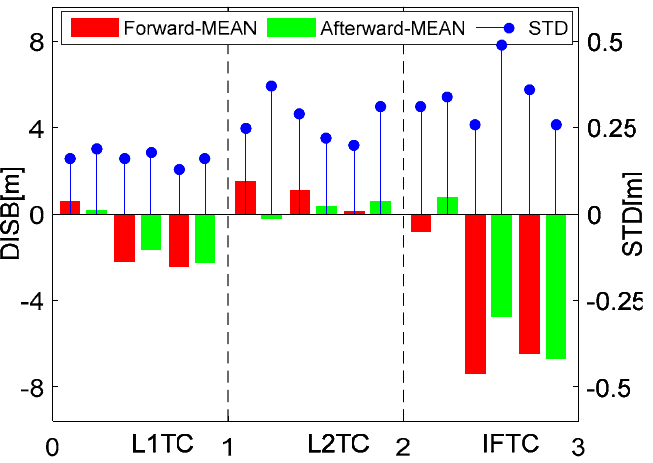
Figure 5. Mean and standard deviation of ISB estimations from the receiver reboot test. The columns from left to right correspond to the L1TC, L2TC, and the IFTC method, respectively. In the L1TC part, the columns from left to right are the ISB estimations of the receiver pairs RC1, RC2, and RC3, respectively. The other parts are also the same as the L1TC part. The mean of the ISB estimations are represented by a red bar before the receivers are rebooted and by a green bar after the receivers are rebooted, and the STDs of the ISB are represented by blue stems.